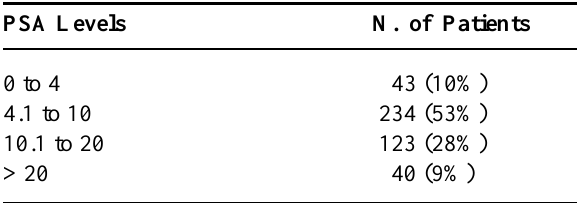
Table 2 – Patient distribution according to pre-operative PSA levels.